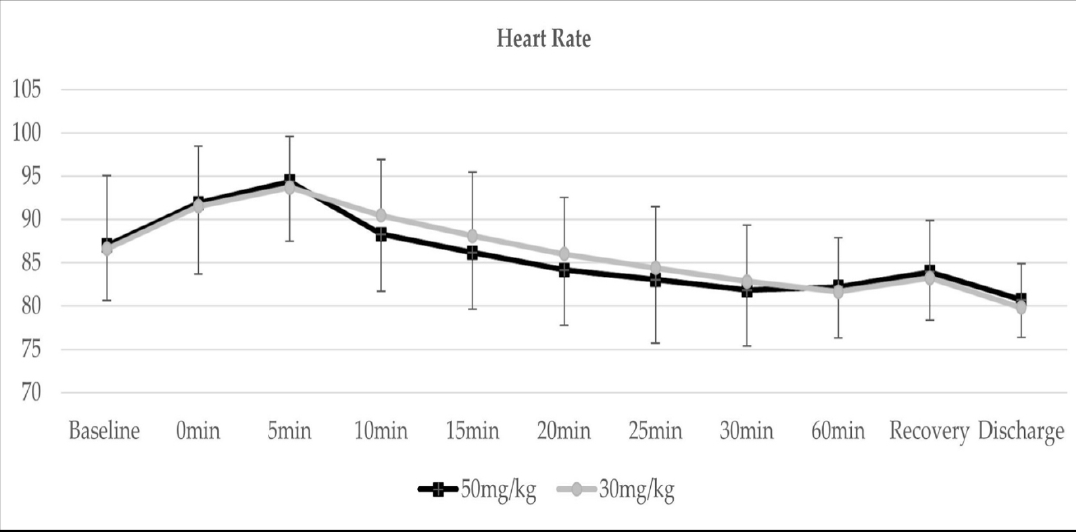
Figure 3. Trend of heart rate, p = 0.150.